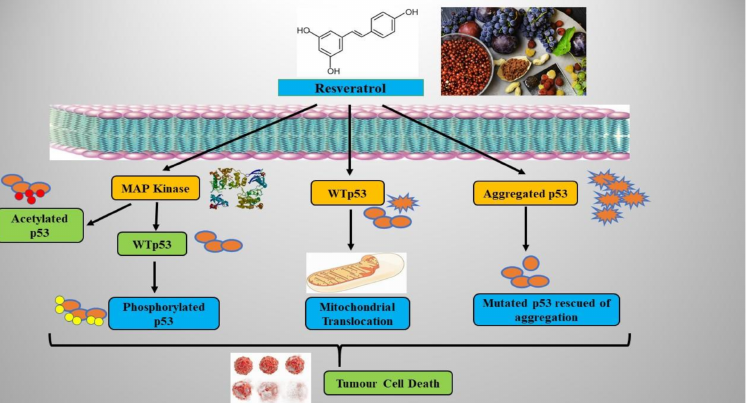
Figure 2. The contribution of p53 in the effects of resveratrol in cancer cells. MAP kinase, mitogen activated protein kinase; WTp53, wild type